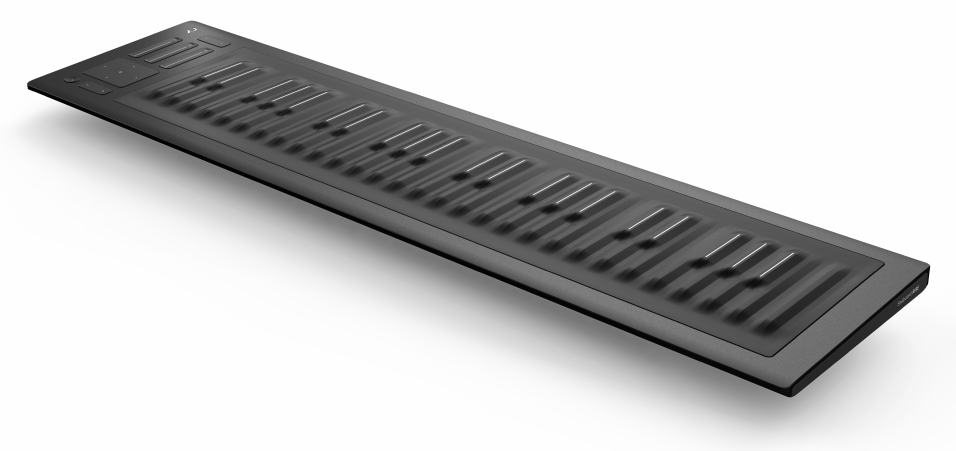
Figure 2. The MIDI controller ROLI Seaboard Rise. Courtesy of ROLI,